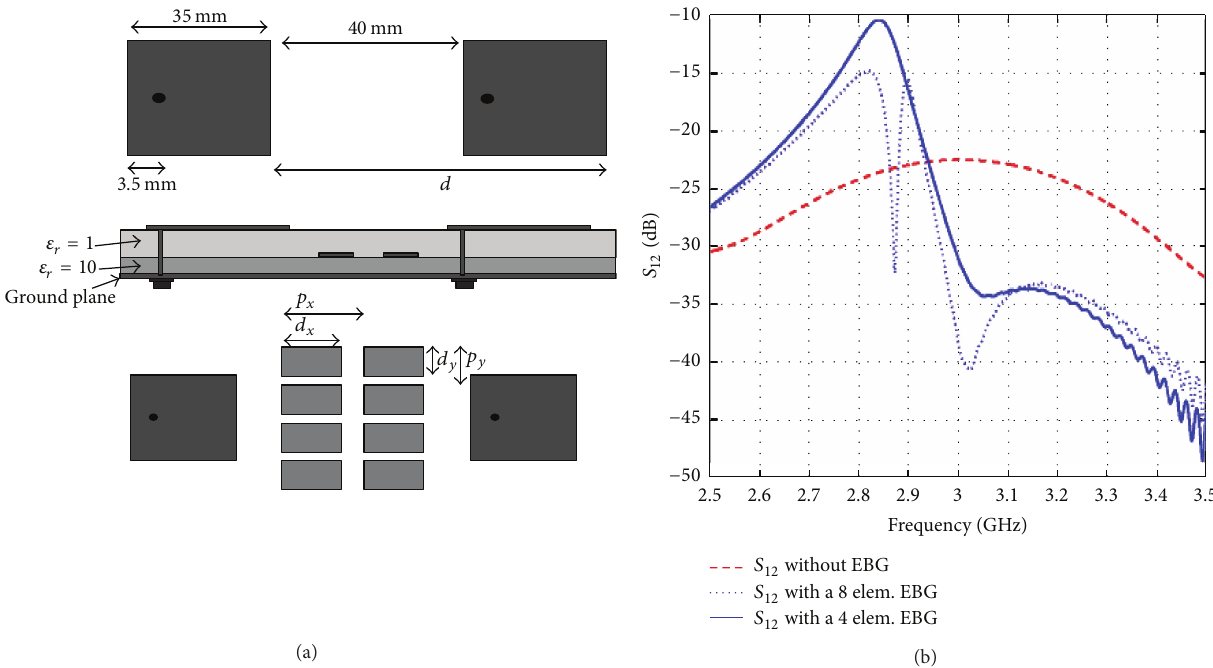
Figure 25: (a) Reference array and array with EBG on multilayer dielectric substrate. (b) Mutual coupling comparison of the array.